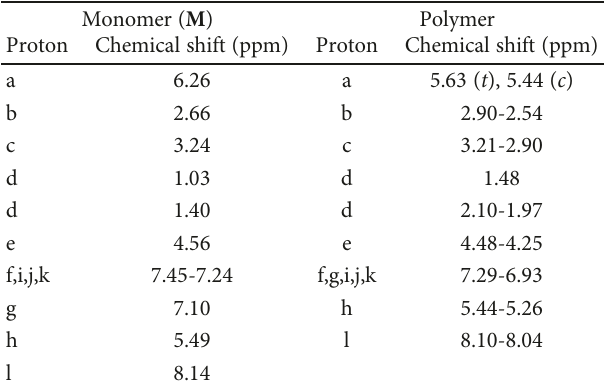
Figure 4: 1 H-NMR spectra of M (a) and its polymer (b, sample 2 ) in CDCl Table 2: 1 H NMR chemical shift assignments for M and its polymer.